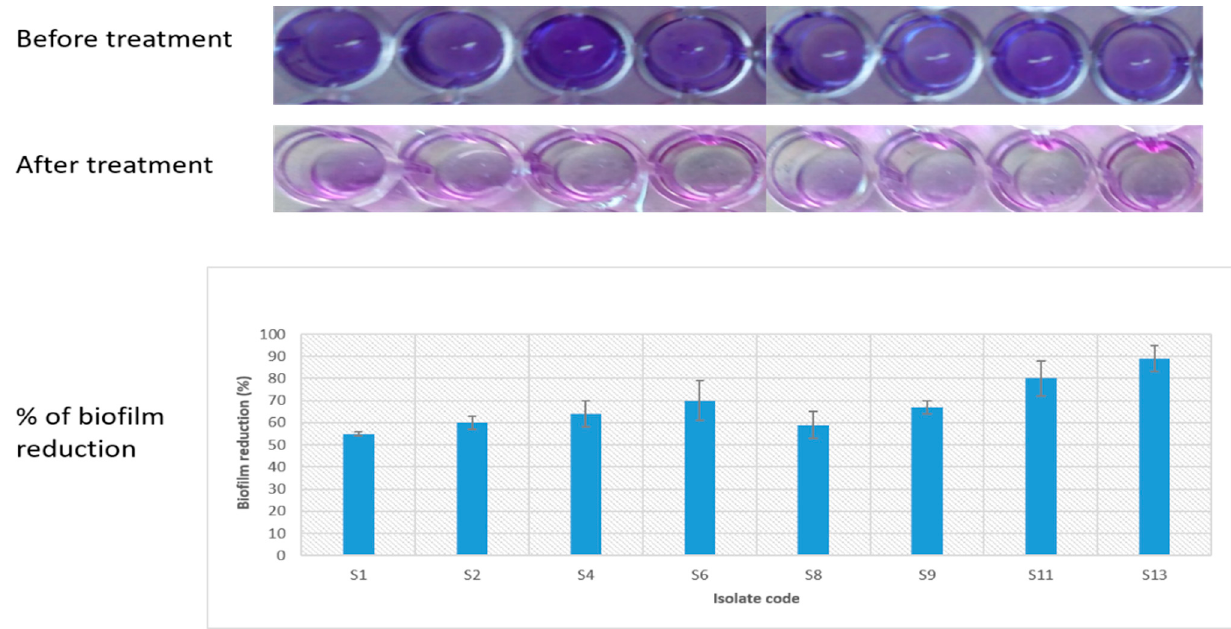
Figure 7. Crystal violet assay for evaluation of the antibiofilm efficiency of CRME against S. enterica isolates showing a significant reduction ( p < 0.05) in biofilm formation in 8 isolates (S1, S2, S4, S6, S8, S9, S11, and S13).